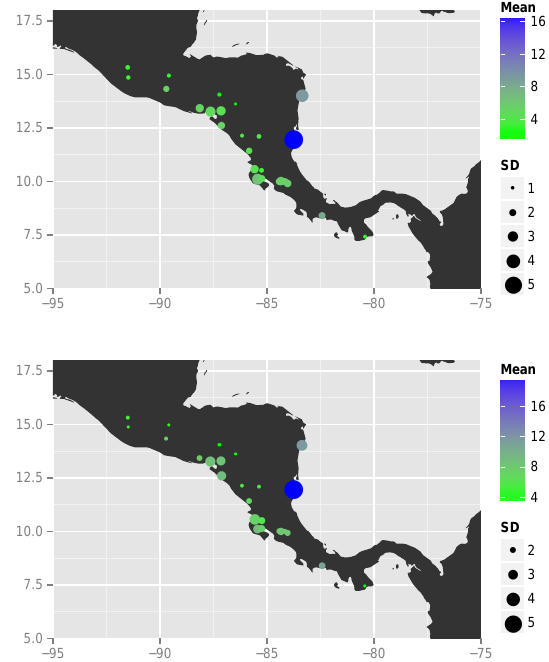
Figure 5. Mean and standard deviation for the MSD intensity (mm, top) and magnitude (mmday − 1 , bottom) for the period 1961–2012. Note the color scale is not the same in both figures, since the inten- sity and magnitude are not necessarily of the same order of magni- tude. The dots size represents the standard